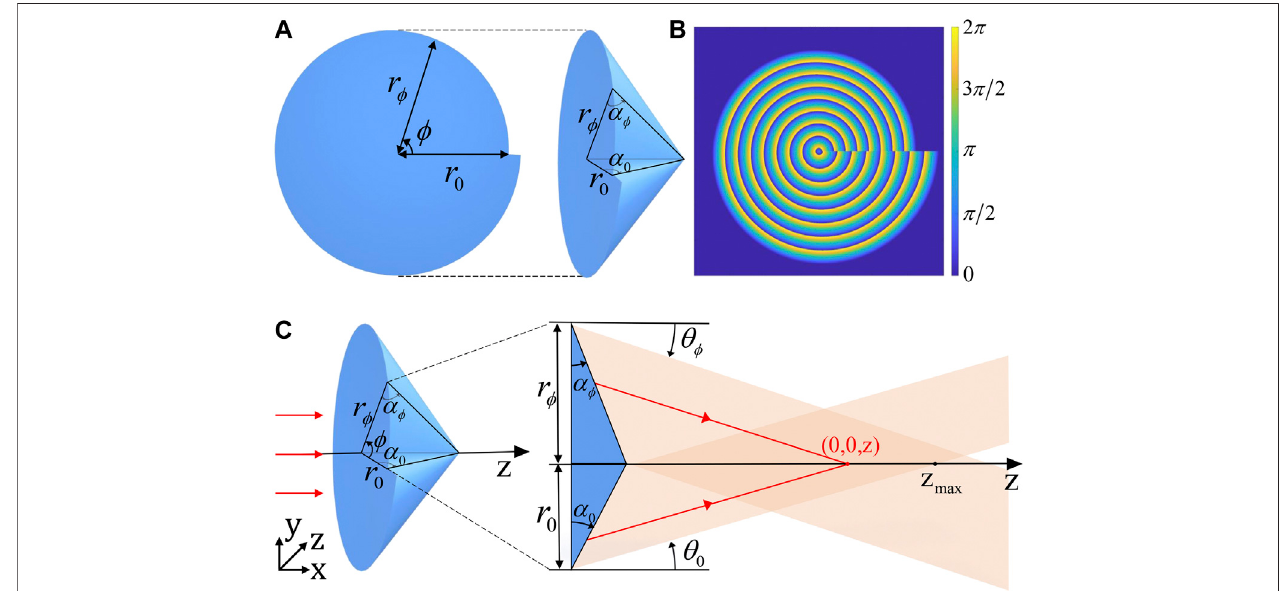
FIGURE 1 | (A) Schematic diagram of the spiral axicon: it has a spiral bottom and a fi xed central height, and a clearer structure is shown in the supplementary material; (B) phase diagram of the spiral axicon; (C) analysis diagram of beam propagation through spiral